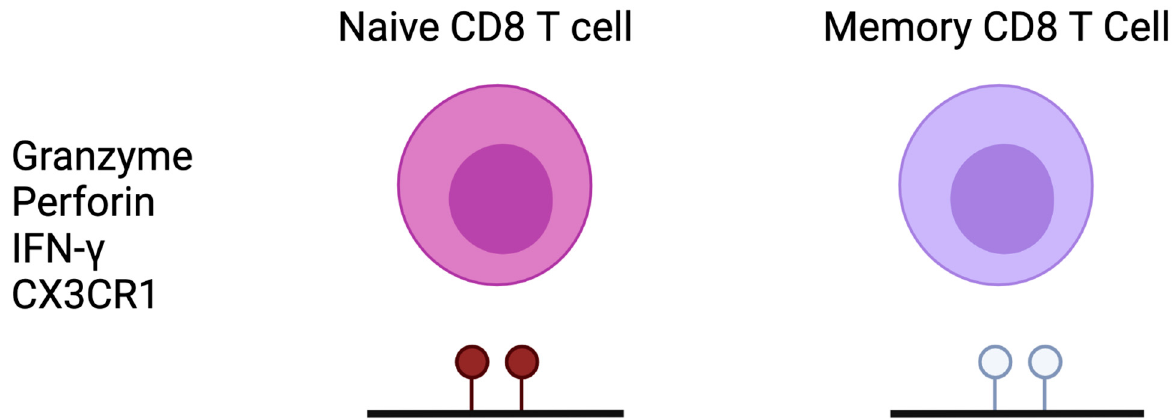
Figure 2. DNA methylation and memory CD8 T cell: memory CD8 T cells presented a decreased DNA methylation of granzyme, perforin, IFN-gamm and CX3CR1 genes.